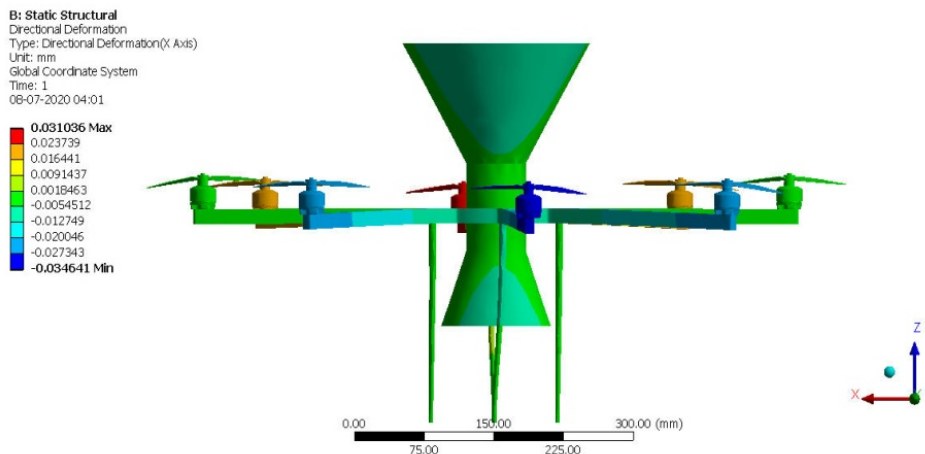
Figure 30. Variations of displacement in the X direction.